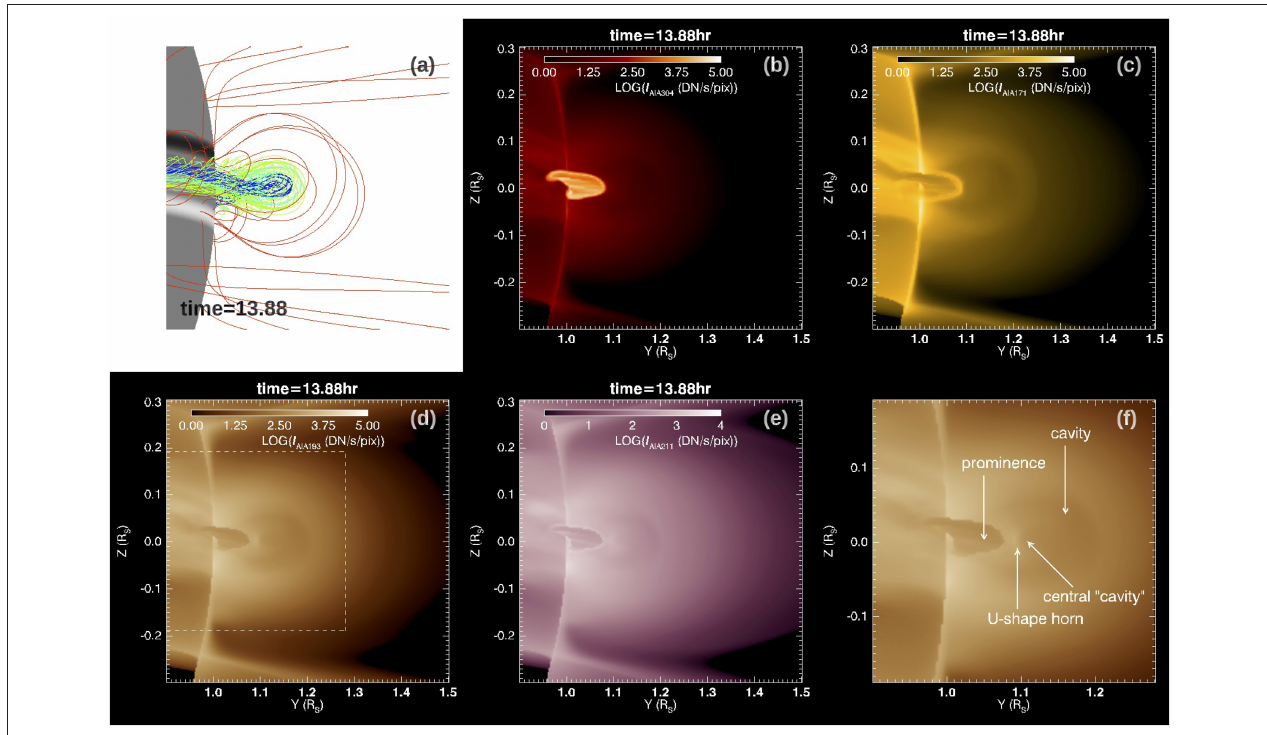
FIGURE 8 | Same as Figure 7 but with the flux rope viewed slightly tilted by 5 ◦